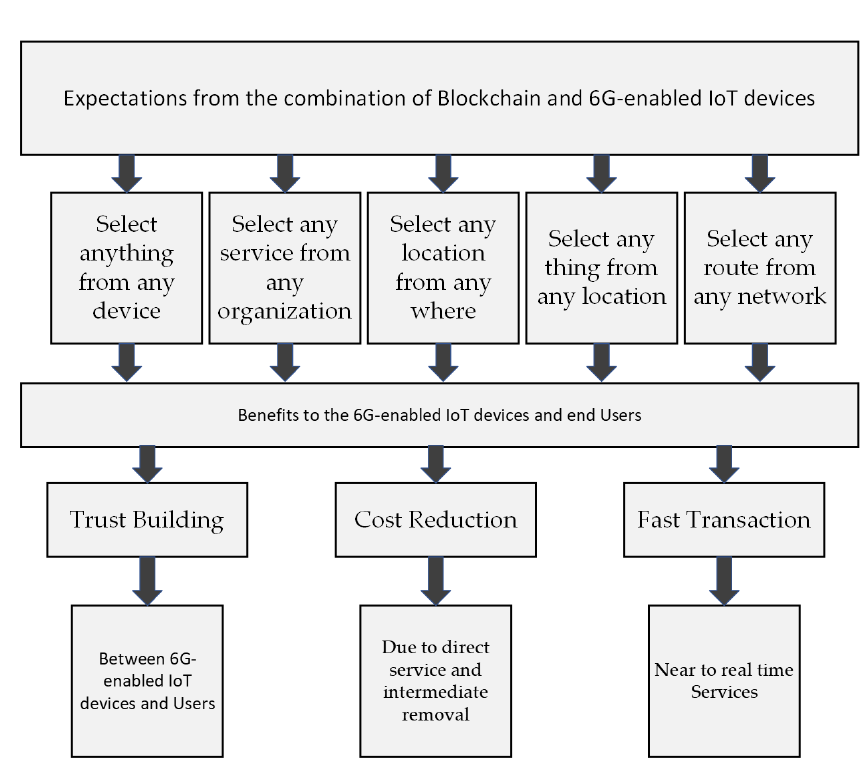
Figure 3. Expansion from the combination of Blockchain and 6G-enabled